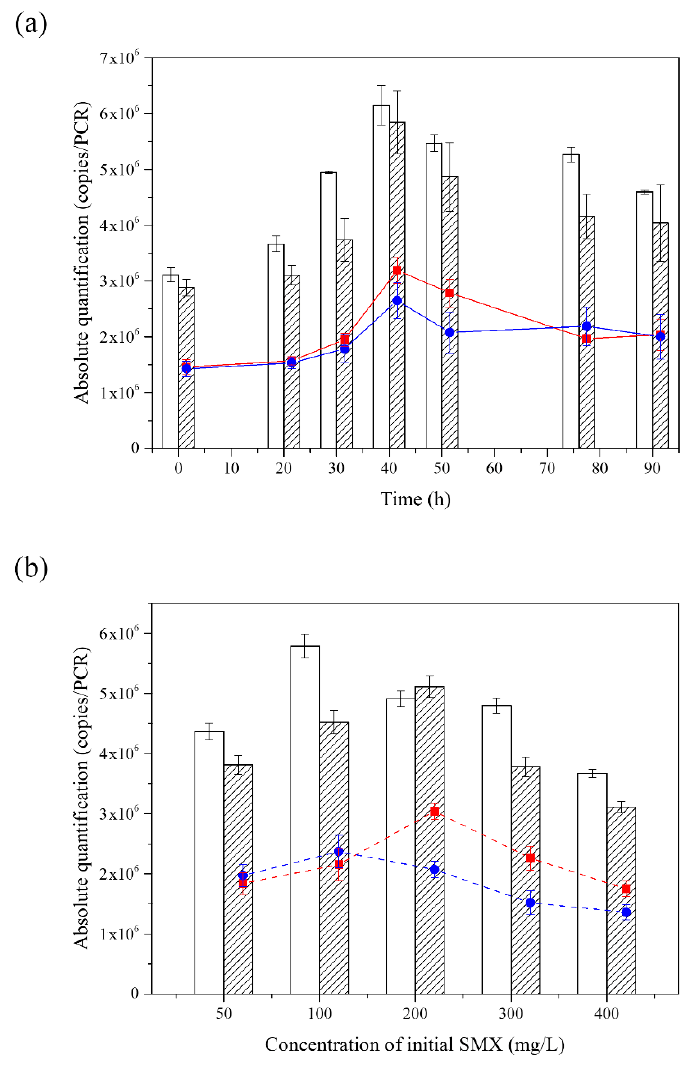
Figure 4. The bar chart represents the consortium (diagonal lines) and the strain YL1 only (white bar). The red line represents the copies of YL1 in the consortium, and the blue line represents the copies of YL2 in the consortium. ( a ) Abundance of YL1 and YL2 during degradation of SMX at 200 mg · L − 1 . ( b ) Abundance of YL1 and YL2 at different initial SMX concentrations.